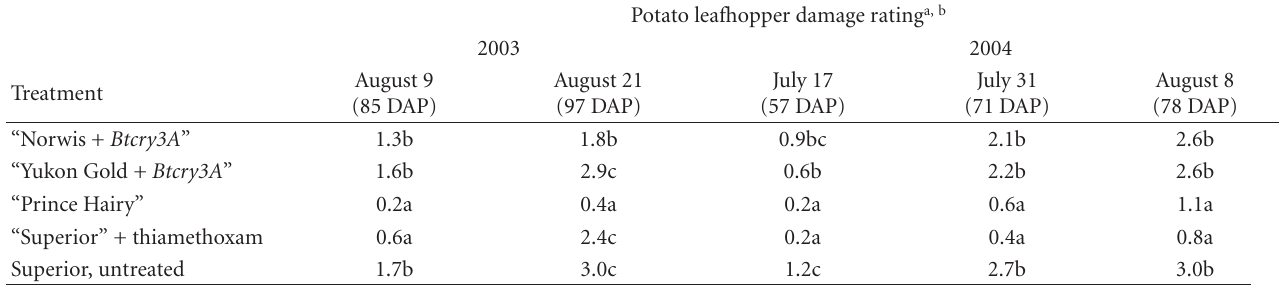
a DAP: days after planting. Table 3: Potato leafhopper damage rating of potato plants in two years of field